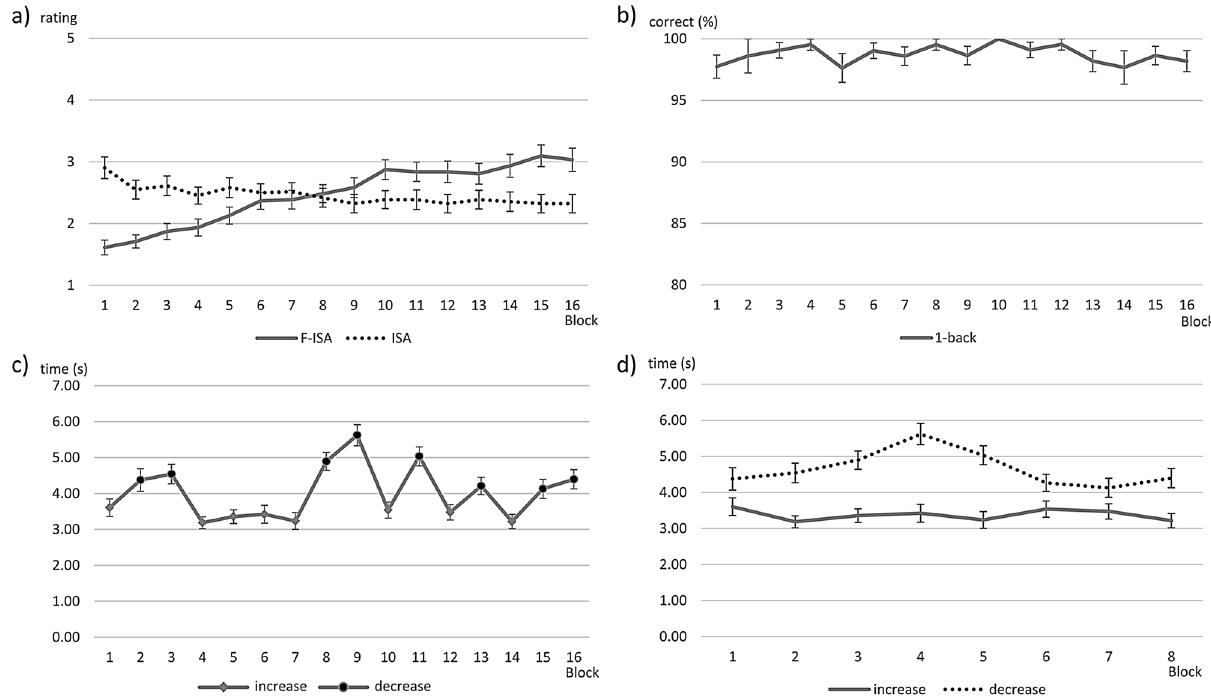
Figure 1. Mean subjective and performance measures across blocks. Error bars indicate SE . ( a ) F-ISA and ISA ratings. ( b ) 1-back accuracy (%). ( c ) Monitoring reaction time (s) including direction of the altitude deviation. ( d ) Monitoring reaction times (s) split by direction.